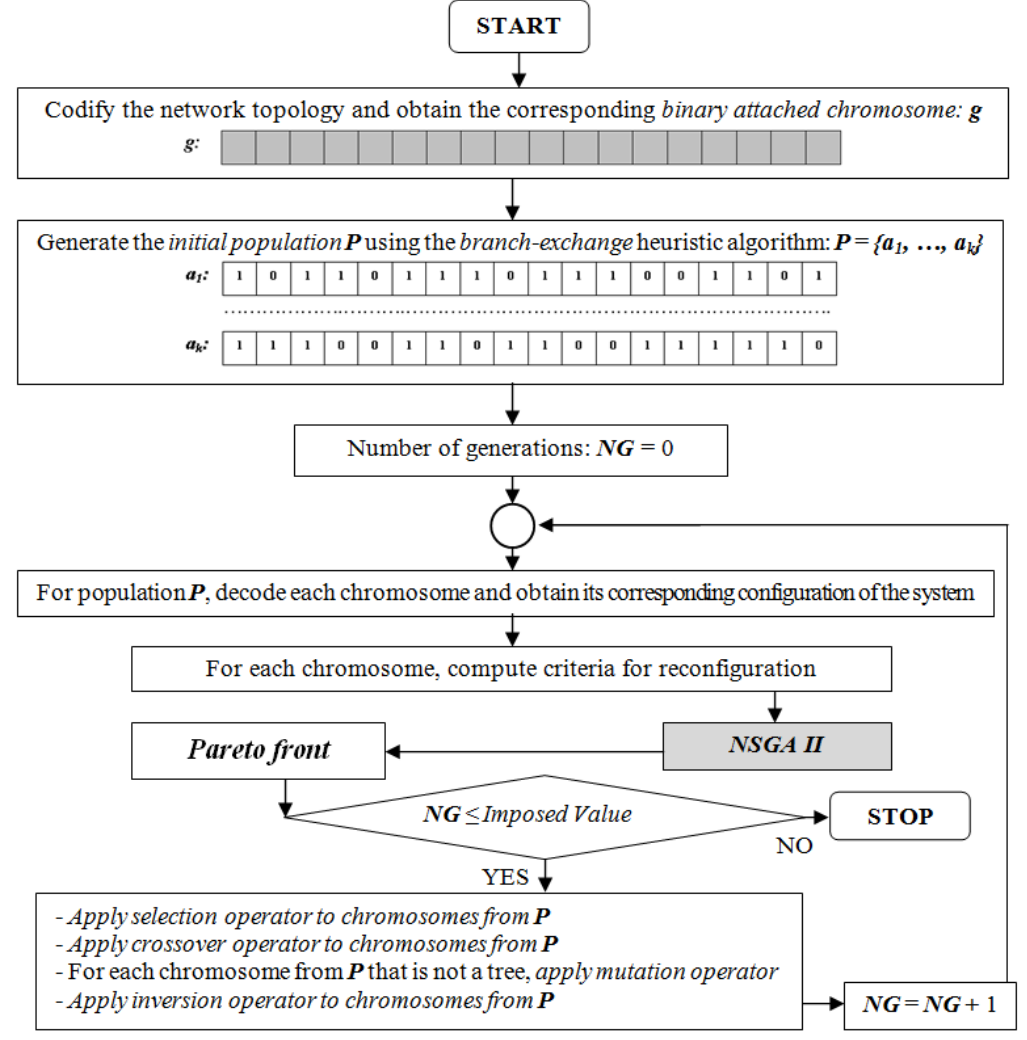
Figure 3. Logical diagram of the proposed algorithm ( MOReco ) dedicated to the reconfiguration of power distribution